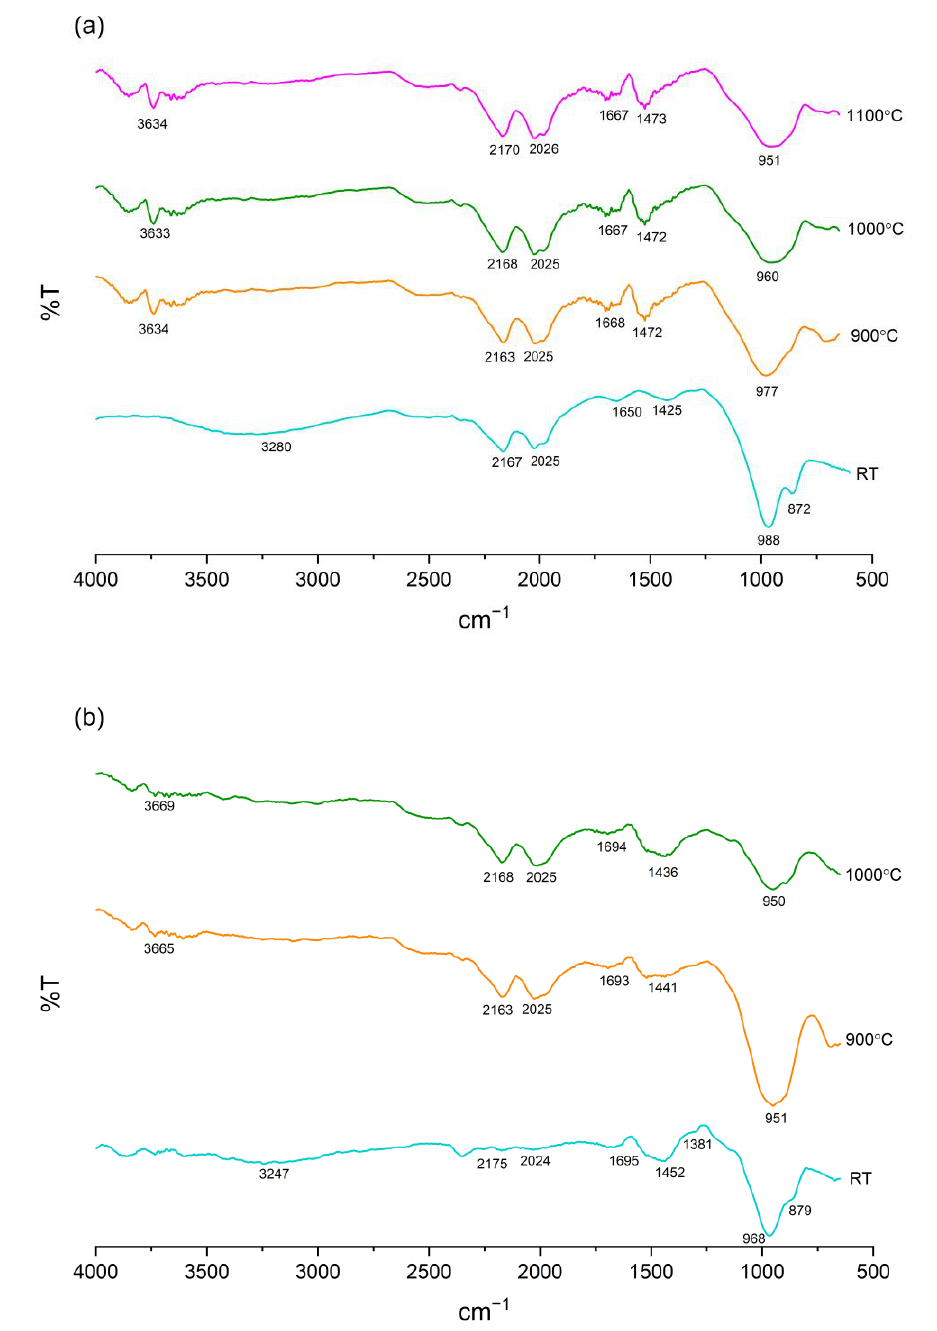
Figure 16. FTIR spectra of ( a ) FAS and ( b ) FAB8 geopolymers at elevated temperatures.